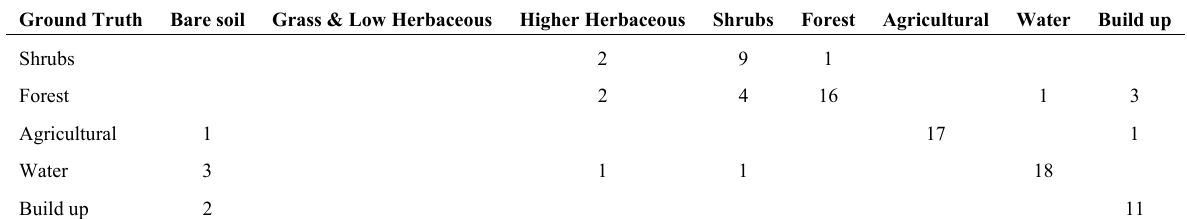
Figure 3. Maximum likelihood classification result of the CHRIS nadir image of the ( a ) Gelderse Poort and ( b ) Millingerwaard (indicated with the black square) into major land cover